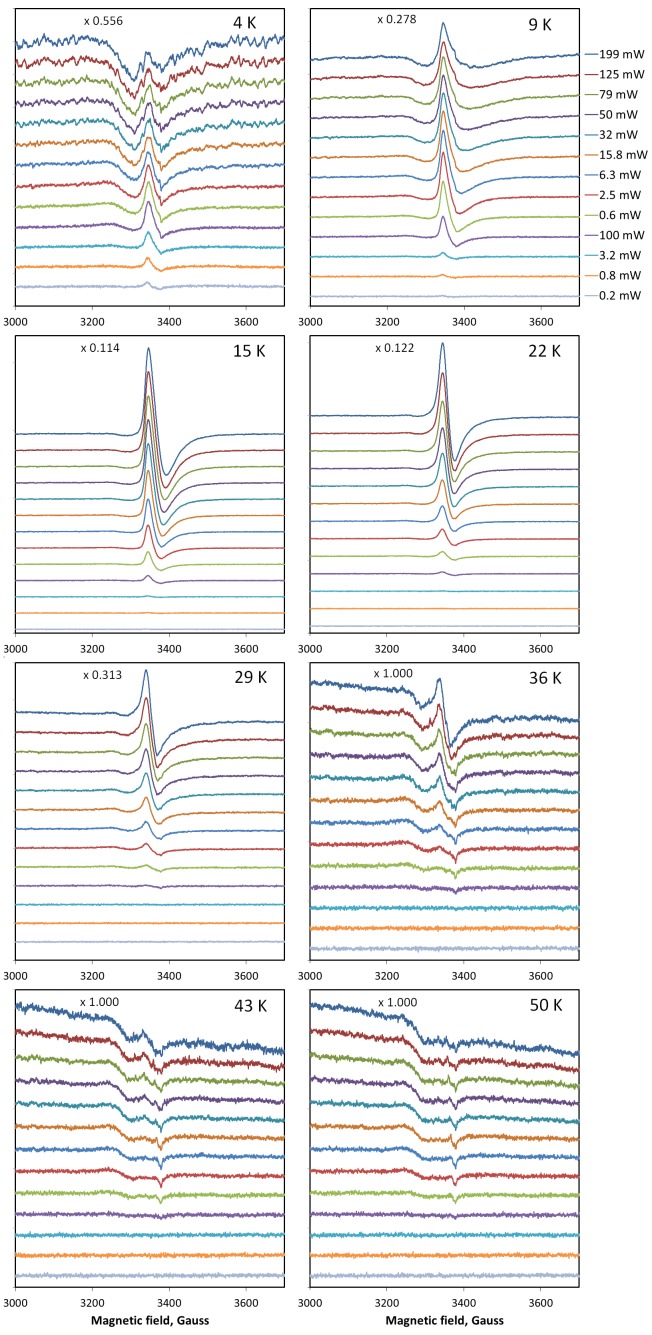
EPR saturation characteristics of the RirA EPR signal.A complete temperature/microwave power saturation map of the RirA EPR signal (at 3 min after aerobic addition of EDTA to RirA). All spectra within each panel are plotted at the same receiver gain, and the relative gain between panels is indicated by the ‘x’ symbol. The broad line at g = 2.05 (to the left from the main signal) results from a minor baseline copper EPR signal. Instrumental settings were as follows: microwave frequency νMW = 9.4647 GHz; modulation frequency νm = 100 kHz; modulation amplitude Am = 3 G; time constant τ = 41 ms; scan rate v = 8.34 G/s.